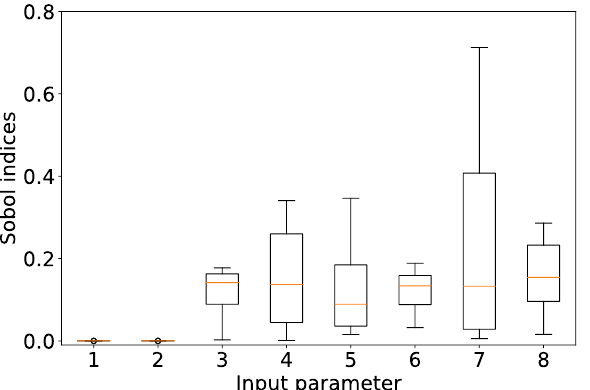
Figure 6. The first order Sobol indices S ( t ) i , weighted by signal variance σ 2 for lead I ( Top ) and lead V1 ( Middle ) for the Monte–Carlo sampled dataset. Note how parameter importance of P3–P8 varies with time and also between leads. All Sobol indices are multiplied by the signal variance to show the relevant influence on the EGC signal. The upper bound for uncertainty in determining Sobol indices (colored band around the mean values) is significantly larger in lead V1 when compared to lead I due to the higher approximation error, cf. Equation (7). ( Bottom ): The box plot of all first order, integrated Sobol indices (cf. Equation (13)) calculated for all leads. S1 and S2 are close to zero. For the other input parameters, we calculate comparable sensitivity measures overall (between 10 and 20%), although the inter-lead variations